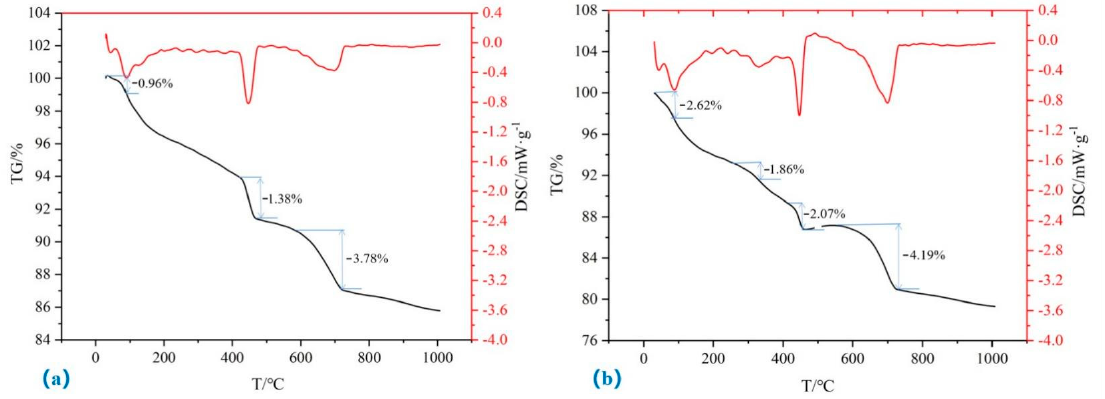
Figure 15. TG-DSC spectra of mortar samples before and after repair.